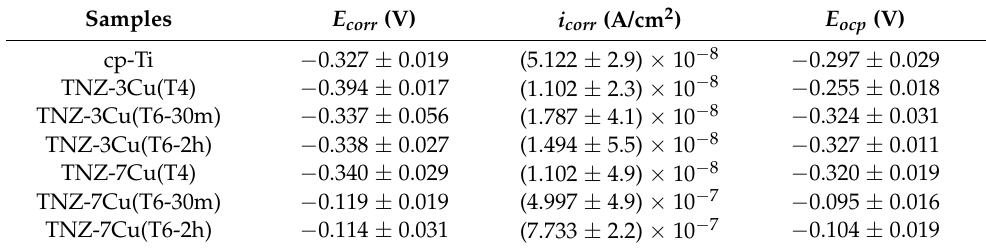
Figure 8. OCP curves and Tafel curves of TNZ-xCu(wt.%, x = 3, 7) and cp-Ti; ( a ) OCP; ( b ) Tafel. Table 2. Electrochemical parameters of TNZ-xCu (wt.%, x = 3, 7) alloys and cp-Ti.